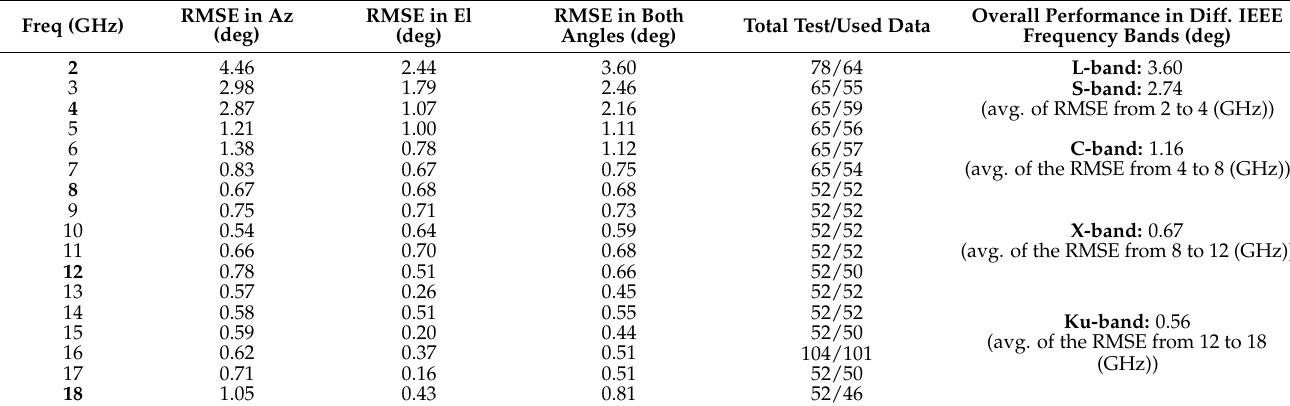
Table 5. RMSE of AoA estimations at frequencies and frequency bands.